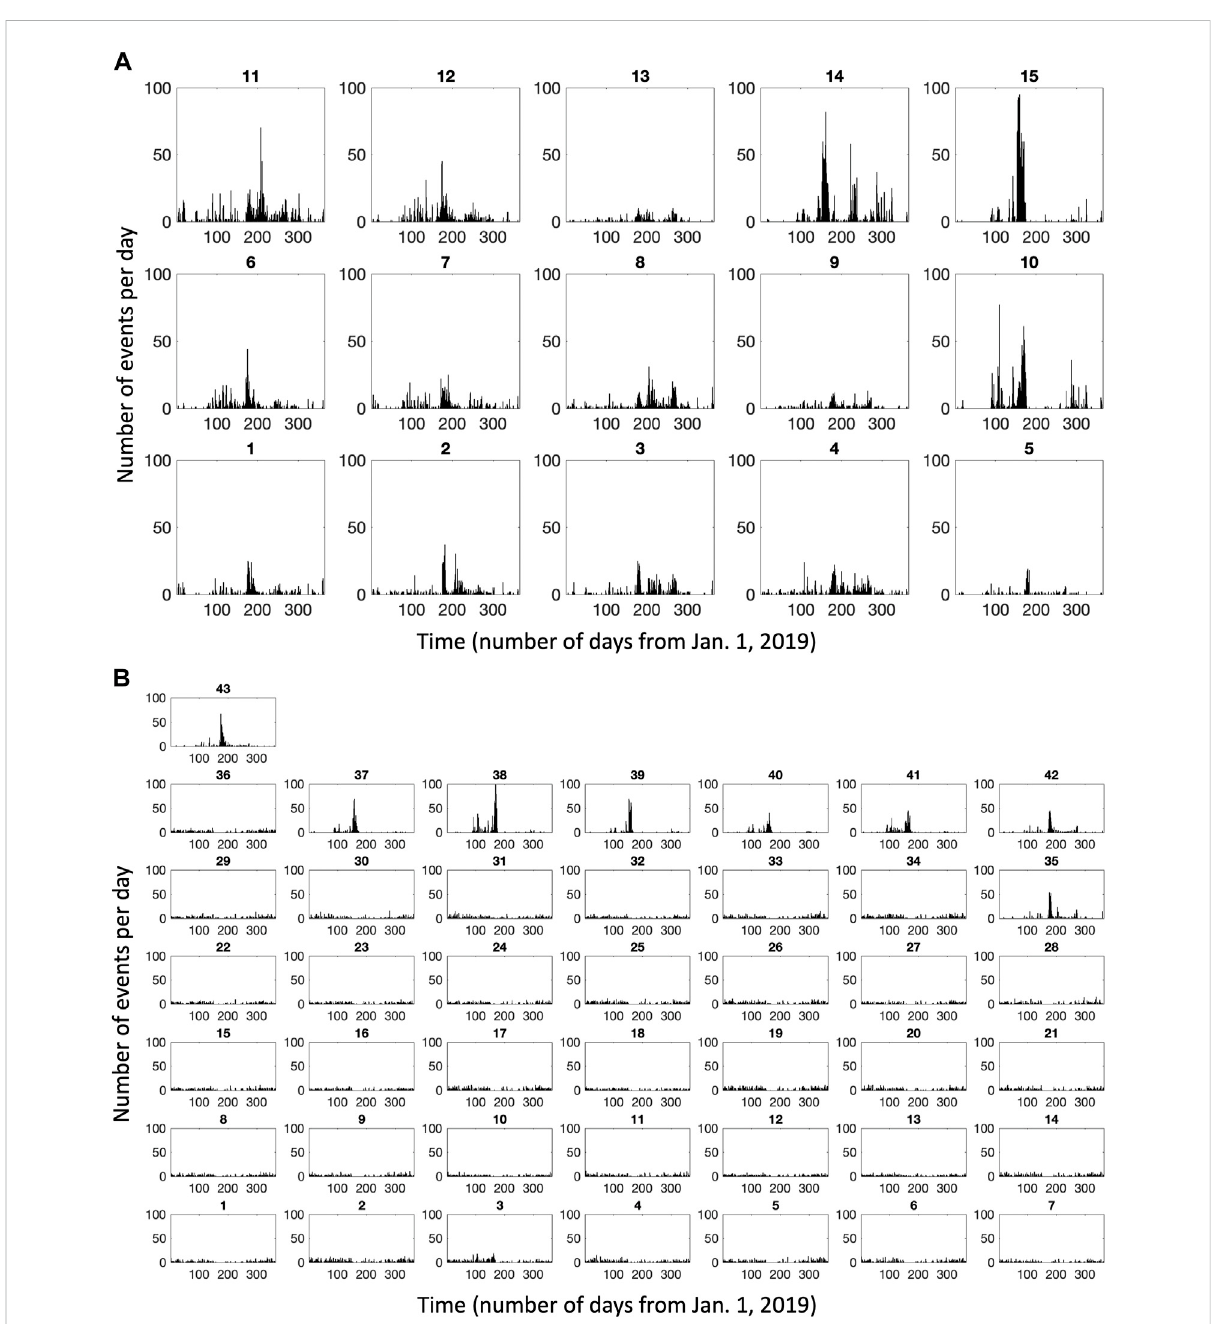
FIGURE 4 Temporal Histograms of cumulative number of events per day belonging to the i th family determined by the CC algorithm (A) events found by the VLP iteration (B) events found by the ULP iteration. The horizontal axis of the histograms indicates the time in 2019 Julian day.